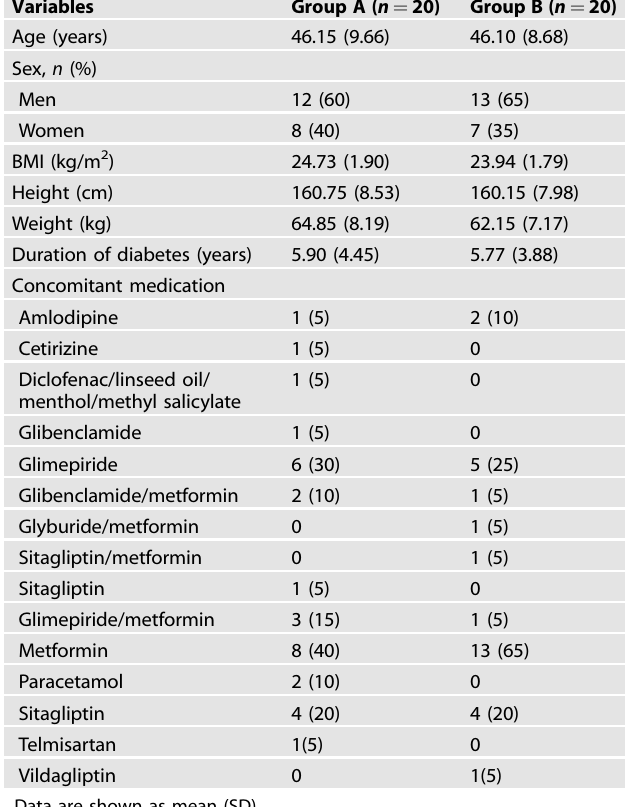
Table 1. Baseline characteristics: the study subjects a